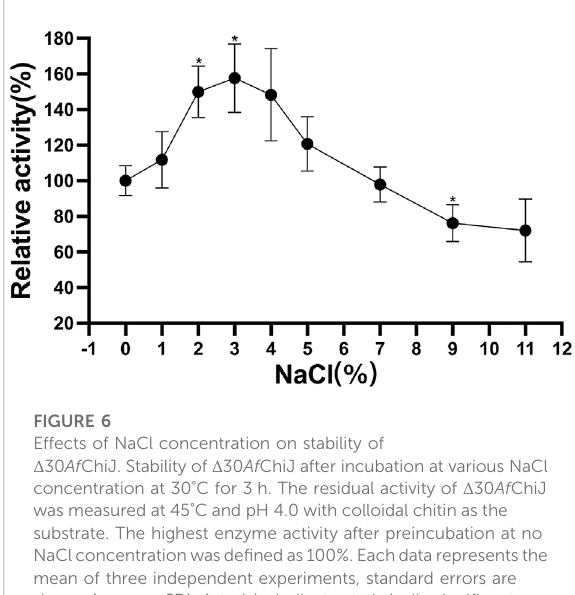
FIGURE 6 Effects of NaCl concentration on stability of Δ 30 Af ChiJ. Stability of Δ 30 Af ChiJ after incubation at various NaCl concentration at 30 ° C for 3 h. The residual activity of Δ 30 Af ChiJ was measured at 45 ° C and pH 4.0 with colloidal chitin as the substrate. The highest enzyme activity after preincubation at no NaClconcentrationwasde fi nedas100%.Eachdatarepresentsthe mean of three independent experiments, standard errors are shown (mean ± SD). Asterisks indicate statistically signi fi cant differences from the control (Student ’ s t-test. *, p < 0.05; **, p <